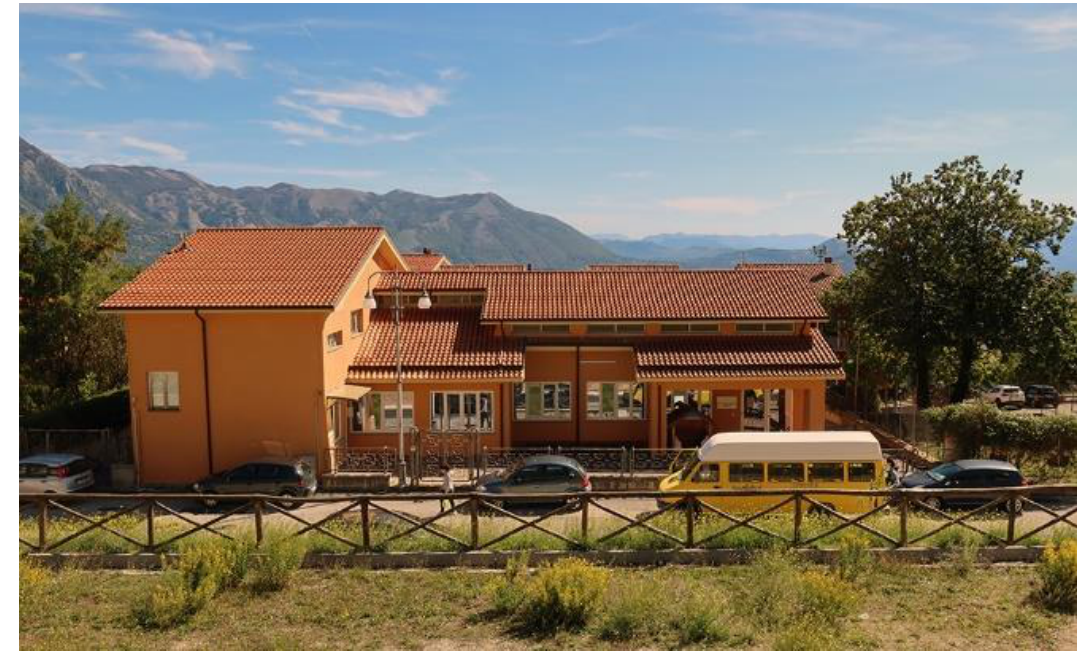
Figure 99. Senerchia: new school complex (photos by [35,36]).